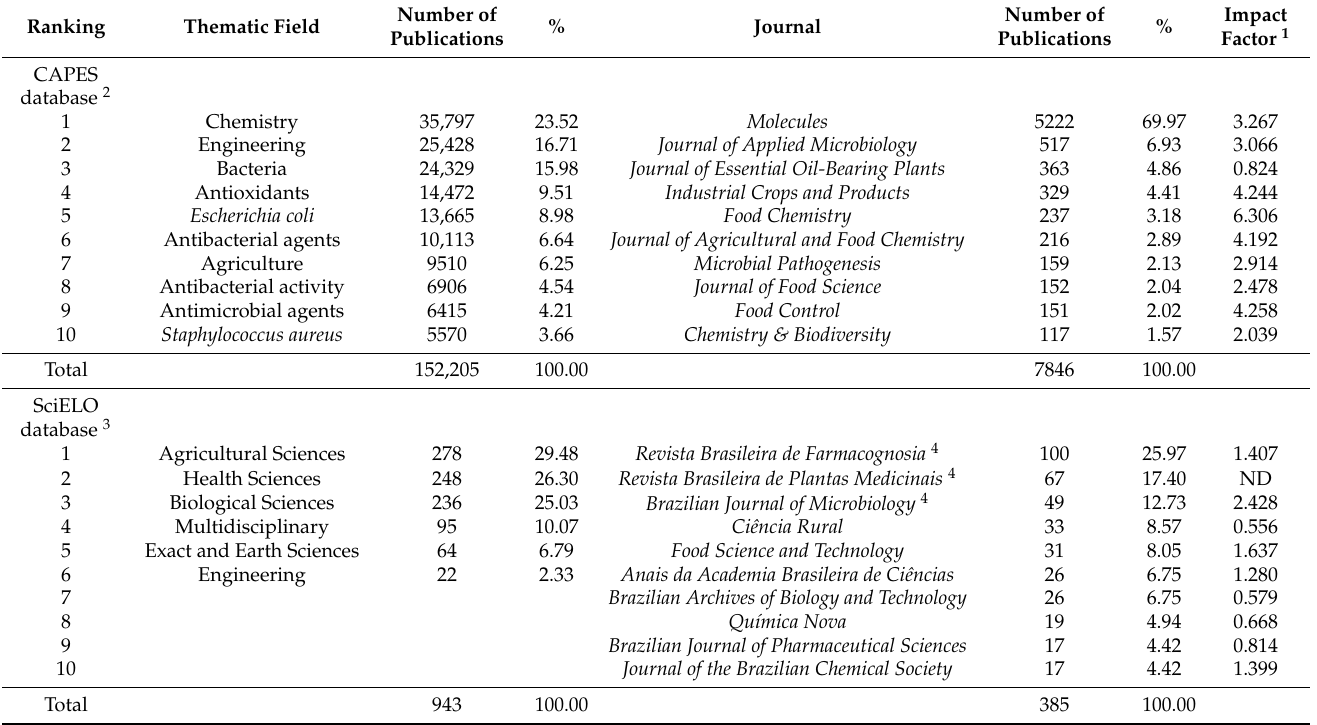
Table 1. Ranking of thematic fields and journals with the highest number of publications on bioactive natural products for microbial